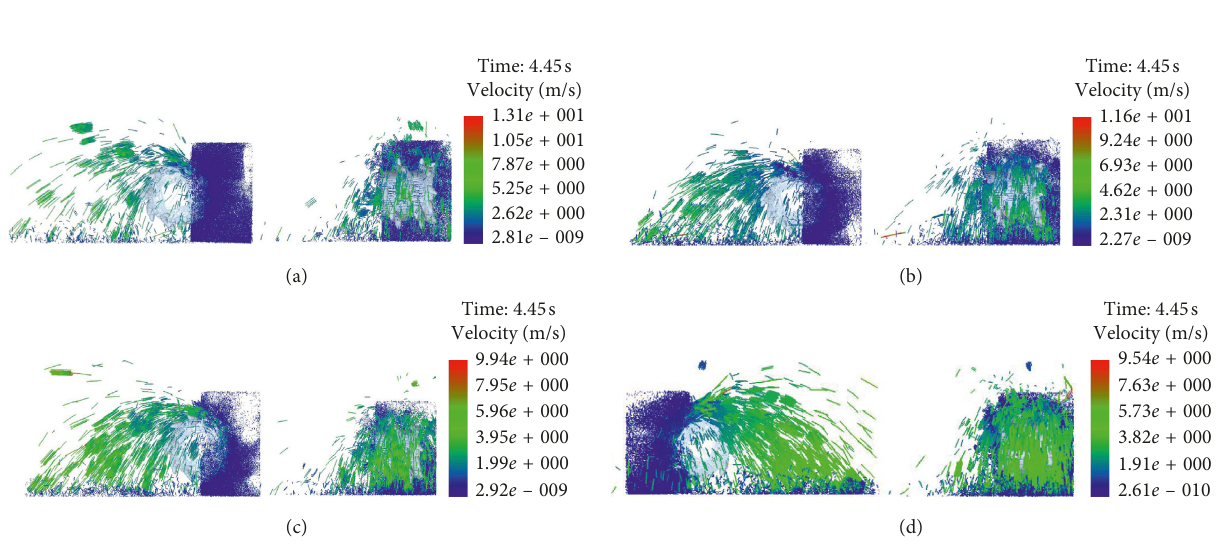
Figure 9: Velocity of the coal particles. (a) V q (cid:31) 3 m/min. (b) V q (cid:31) 4m/min. (c) V q (cid:31) 5 m/min. (d) V q (cid:31)